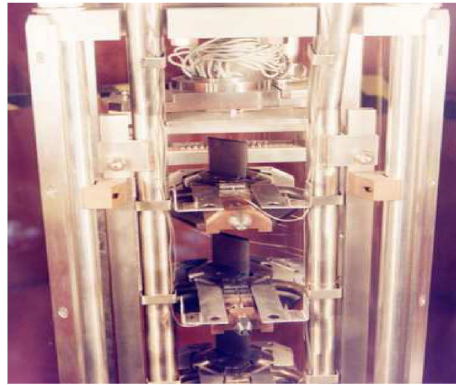
FIG. 2. Picture of the ISIS muon target. There are three targets on a rack which is lowered in the proton beam path during